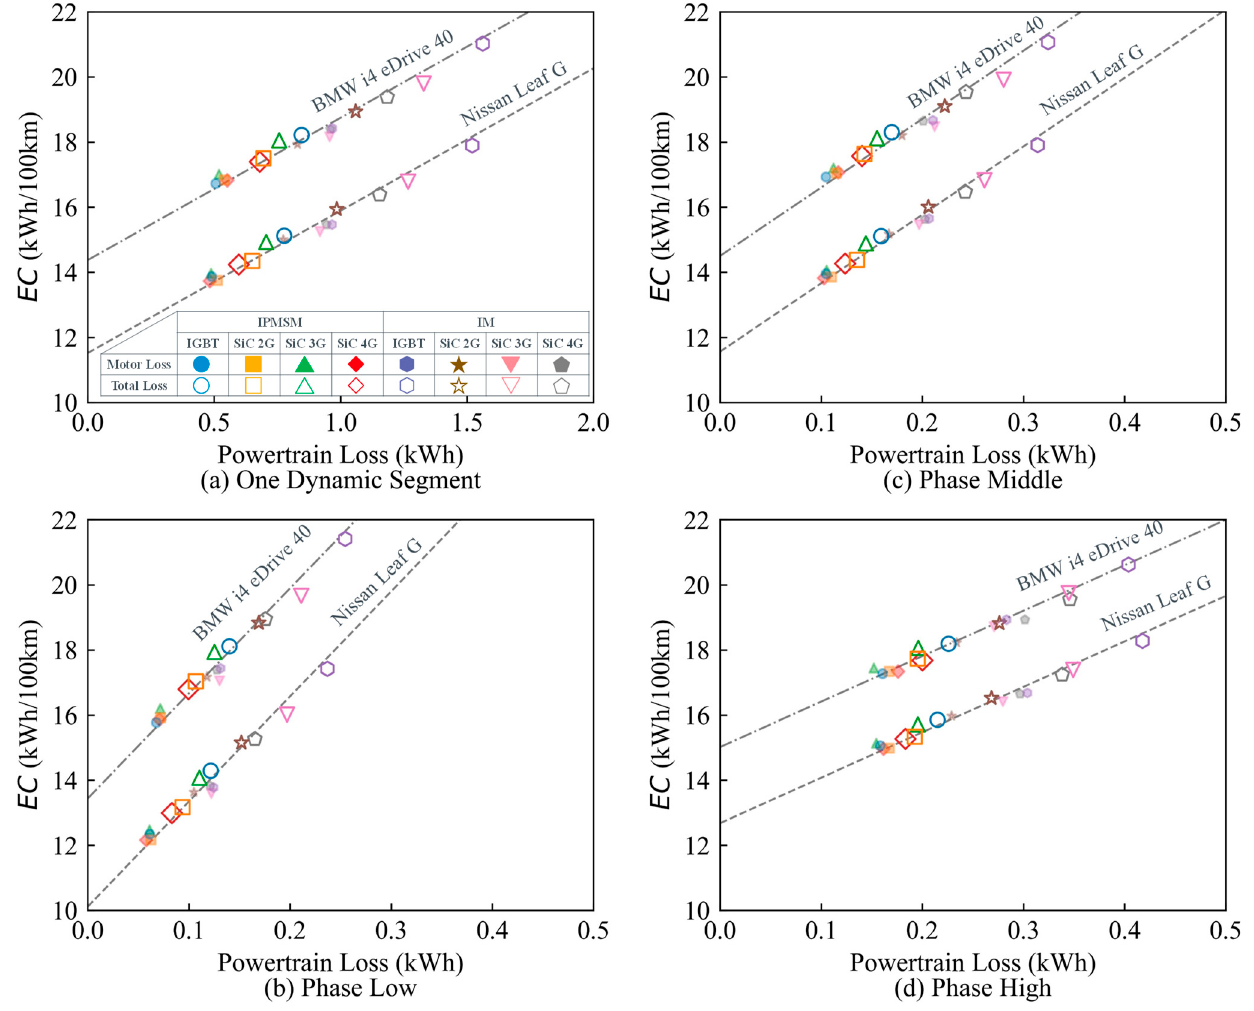
Figure 5. Energy consumption vs. powertrain loss of each phase. The filled markers in Figure 3 represent motor loss. The motor loss increases in the order of low, middle, and high phase as drive distance increases. The markers are roughly overlapped if grouped by the target vehicles and the motor type except SiC-2G of IM. The open markers mean the total value of motor loss and inverter loss. The distance between the filled and the open marker of the same color and shape shows the amount of inverter loss and the amount of improvable energy consumption. Figure 5 helps to visually understand the ratio and the amount of motor and inverter loss, and the effect of each loss on energy